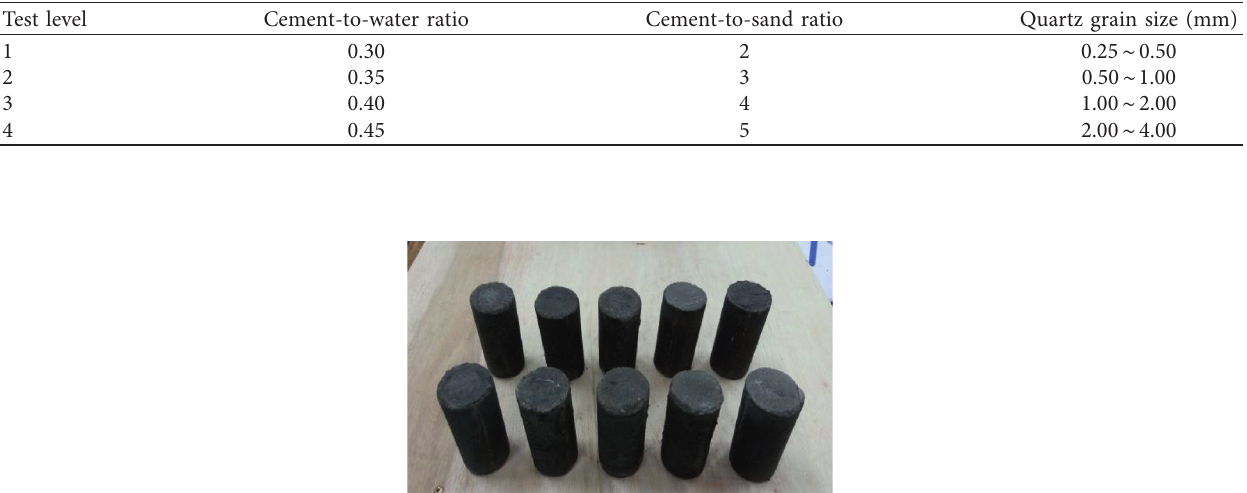
Table 1: Orthogonal design levels of quasi-conglomerate similar material.